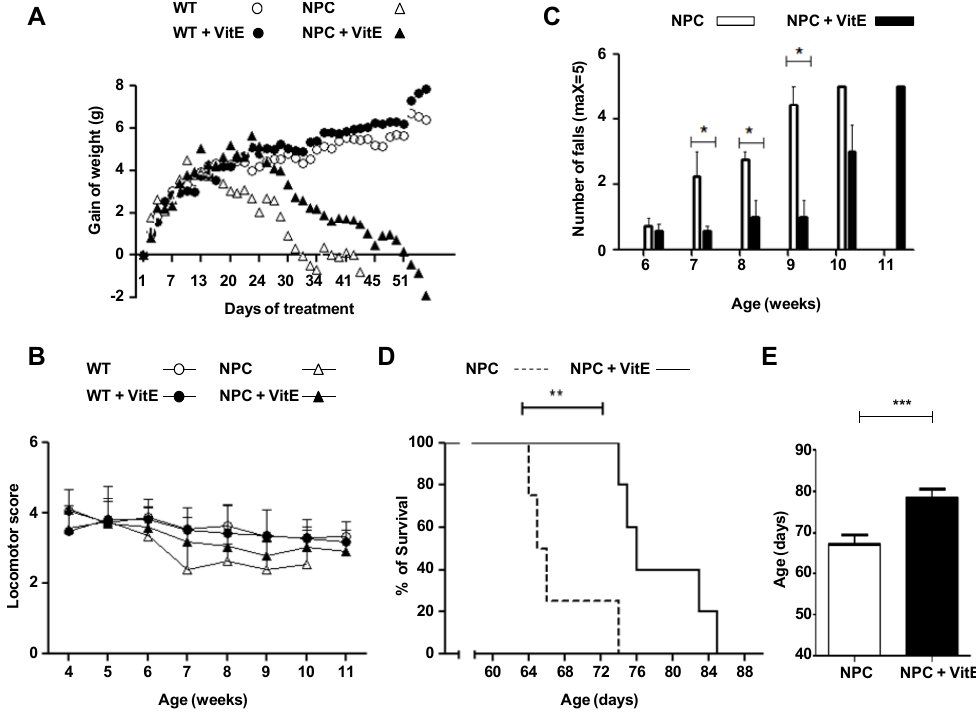
Figure 1. Vitamin E treatment increases survival and improves locomotor function of NPC mice. Wild-type (WT) and NPC mice received vitamin E (Vit E) (2000 IU/kg DL -alpha tocopherol acetate) or control diets starting at p28. ( A ) Weight was registered during the full period of treatment; ( B and C ) Motor coordination was assessed weekly by the hanging test and the beam test, respectively. For A and B white and black circles are shown for control- and Vit E-treated WT mice and white and black triangles are shown for control- and Vit E-treated NPC mice. For C white and black bars are shown for control- and Vit E-treated NPC mice. Control- and Vit E-treated WT mice did not fall down in this test (bars for these groups are not shown); ( D ) Survival was determined by continuing with the treatment until death. The dotted and solid lines are shown for control- and Vit E-treated NPC mice; ( E ) Mean survival age graphic. White and black bars are shown for control- and Vit E-treated NPC mice. Data are shown as mean ± SE, except for A in which SE are not shown to improve the visualization of each group. * p <0.05, ** p < 0.01, *** p < 0.0001. For A – C the following number of animals were used: WT control n = 6, WT Vit E n = 9, NPC control n = 8, and NPC Vit E n = 8. For D and E survival was measured in a group of 4 and 5 NPC mice fed with control and Vit E diets,